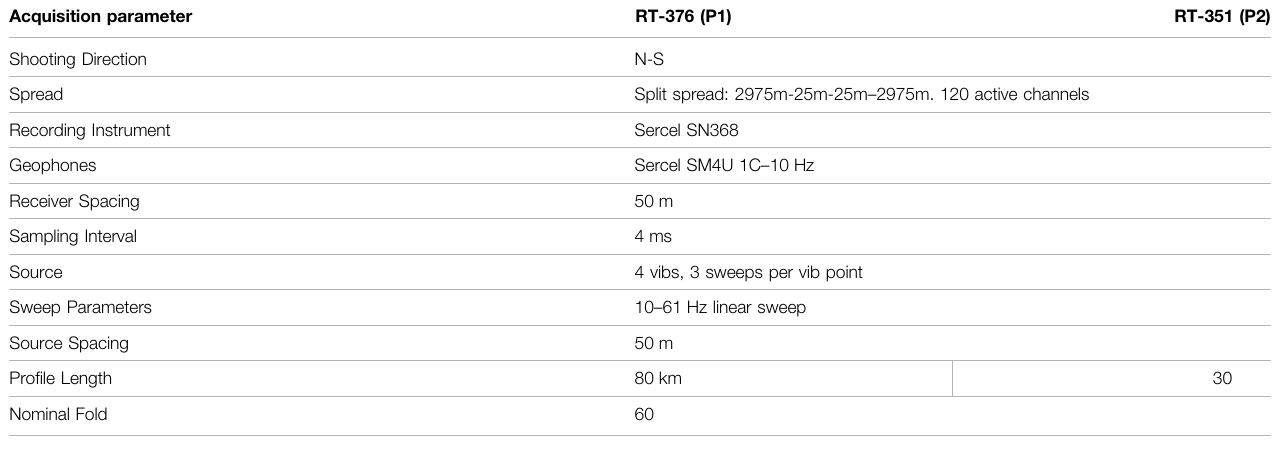
TABLE 1 | Acquisition parameters for pro fi les P1 and P2